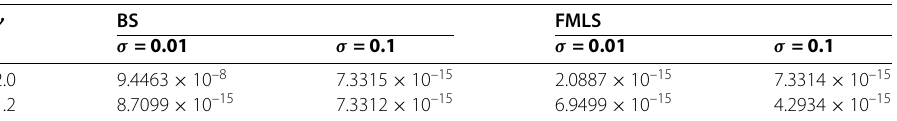
Table 1 Global optimum residual errors R ( v ij ) for NP = 20